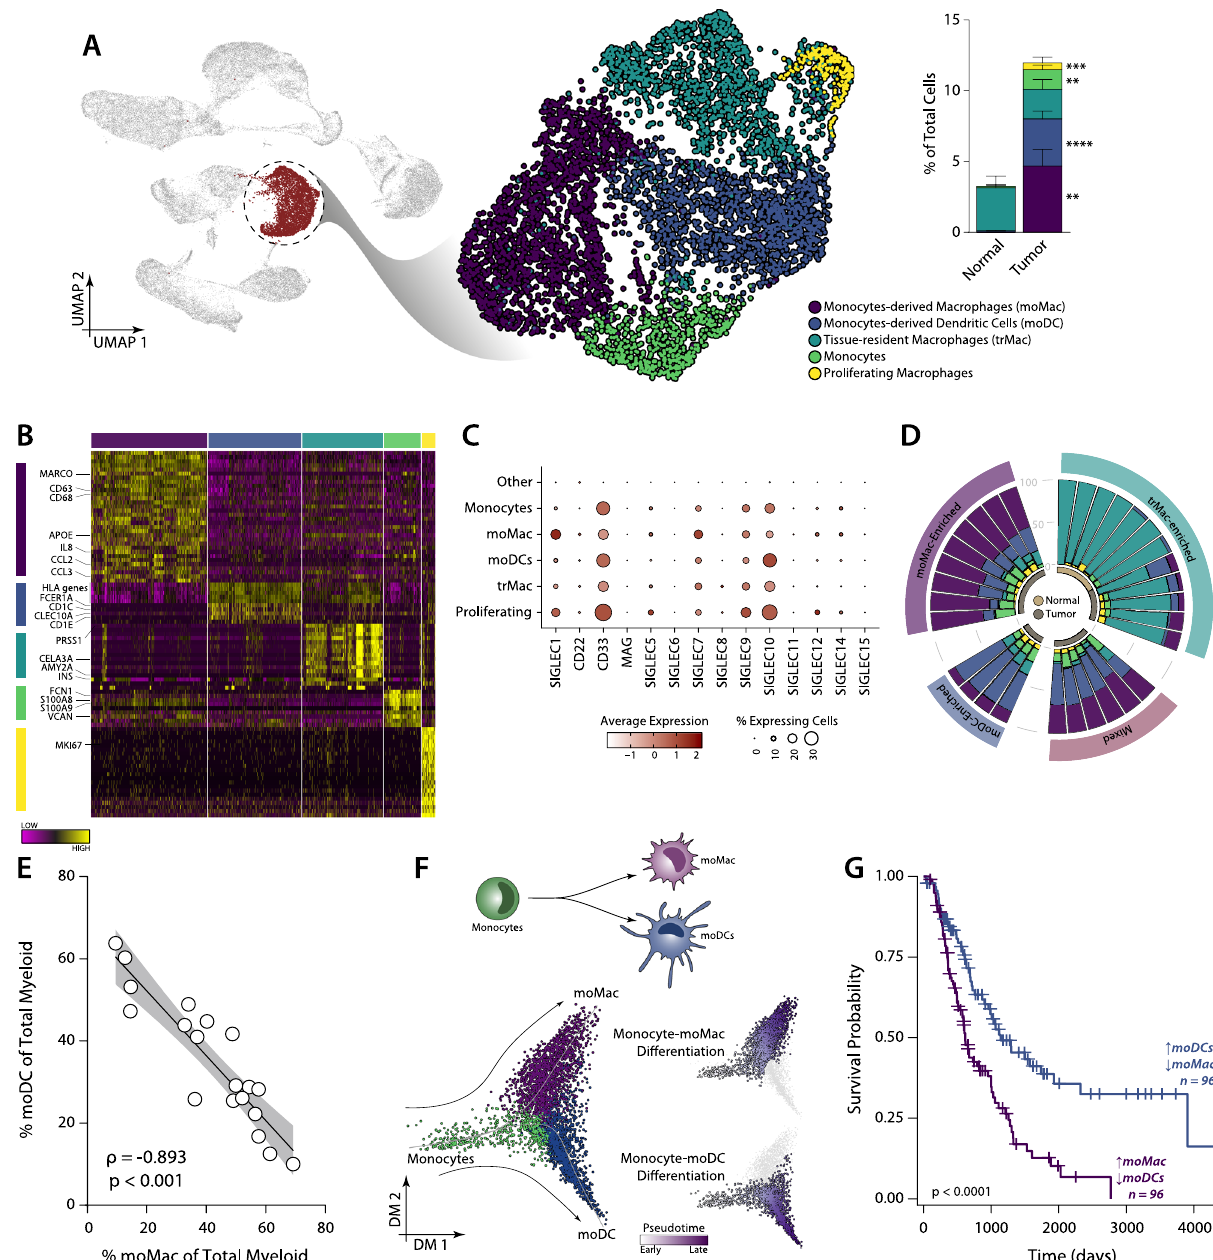
Fig. 3 Characterisation of the myeloid cells in PDAC. A Characterisation and quanti fi cation of the myeloid cell population found in the scRNA-Seq analysis of PDAC tumours from Peng et al. Data presented as mean values ± SEM. B Heatmap highlighting the markers characterising each myeloid population. C Expression of Siglec receptors in the different myeloid populations. D Clustering of patients using the presence of myeloid populations distinguishes patient groups. E Correlation between the moDC and moMac as a % of total myeloid cells. Spearman correlation coef fi cient, p value and 95% con fi dence interval are depicted in the fi gure. F Analysis of the differentiation of monocytes towards dendritic cells or macrophages using diffusion map (using the R package destiny ) and pseudotime ( slingshot ). G Survival analysis based on a moMac/moDCs ratio Score in bulk transcriptomic data using the Log-rank test. moMac/moDC ratio Score was de fi ned as the difference between a moMac and a moDCs Score (Score moMac − Score moDCs ). Top and bottom thirds were used to de fi ne samples enriched in moMac or moDCs, respectively. Data set shown: